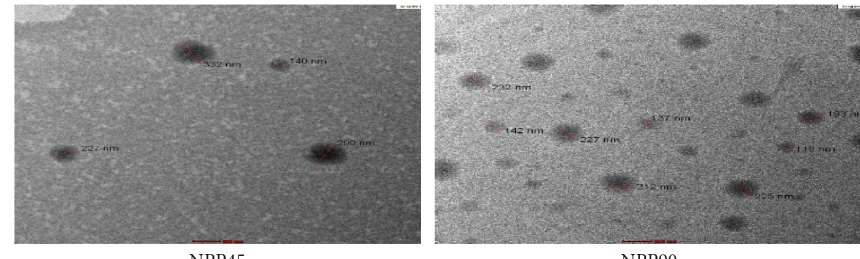
Figure 2: TEM of nano-pomegranate peel fractions (NPP45 and NPP90).